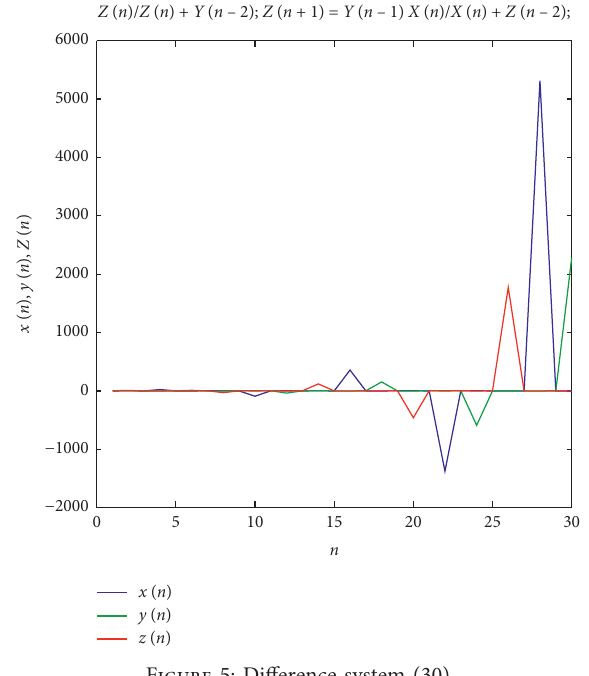
Figure 5: Difference system